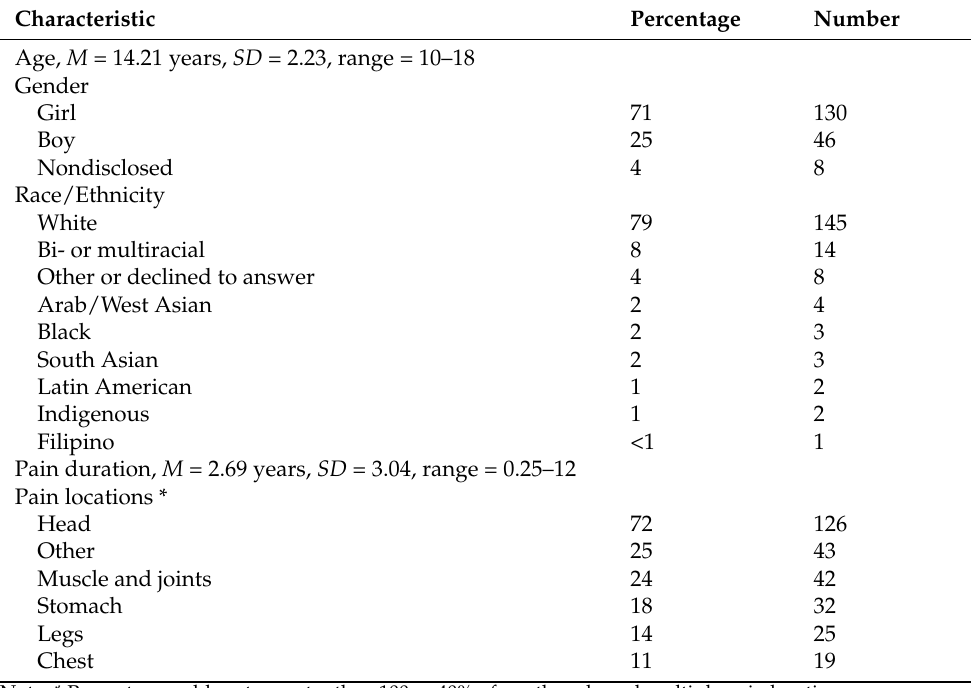
Table 1. Sociodemographic and pain characteristics of the sample.